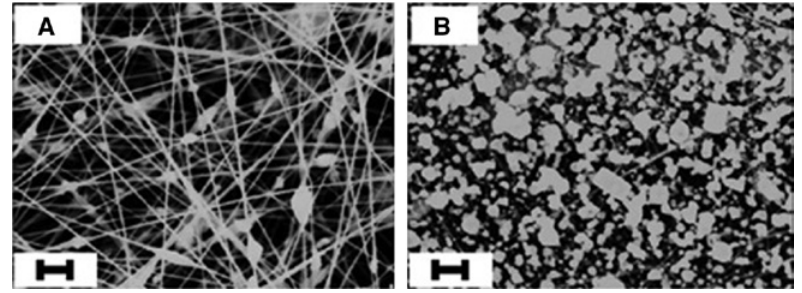
hybrid nanofibers on the cellulose substrate (A) before and (B) after filtration testing. All scale Figure 4: SEM images of 0.5 g/ft 2 PAN/TiO 2 bars are 3 mm. For details, see Ref. [29]; reprinted with permission from Elsevier.